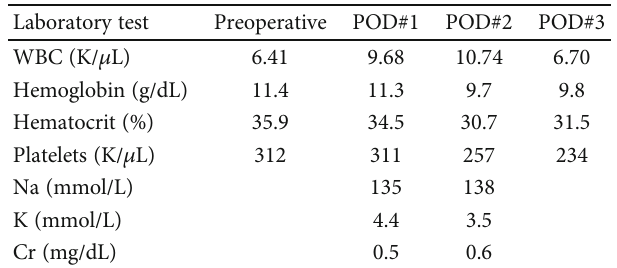
Table 1: Laboratory